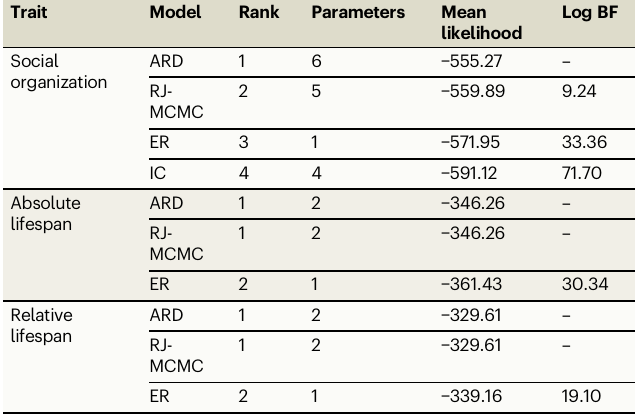
Table 1 | Comparison of evolutionary models for social orga- nization and longevity